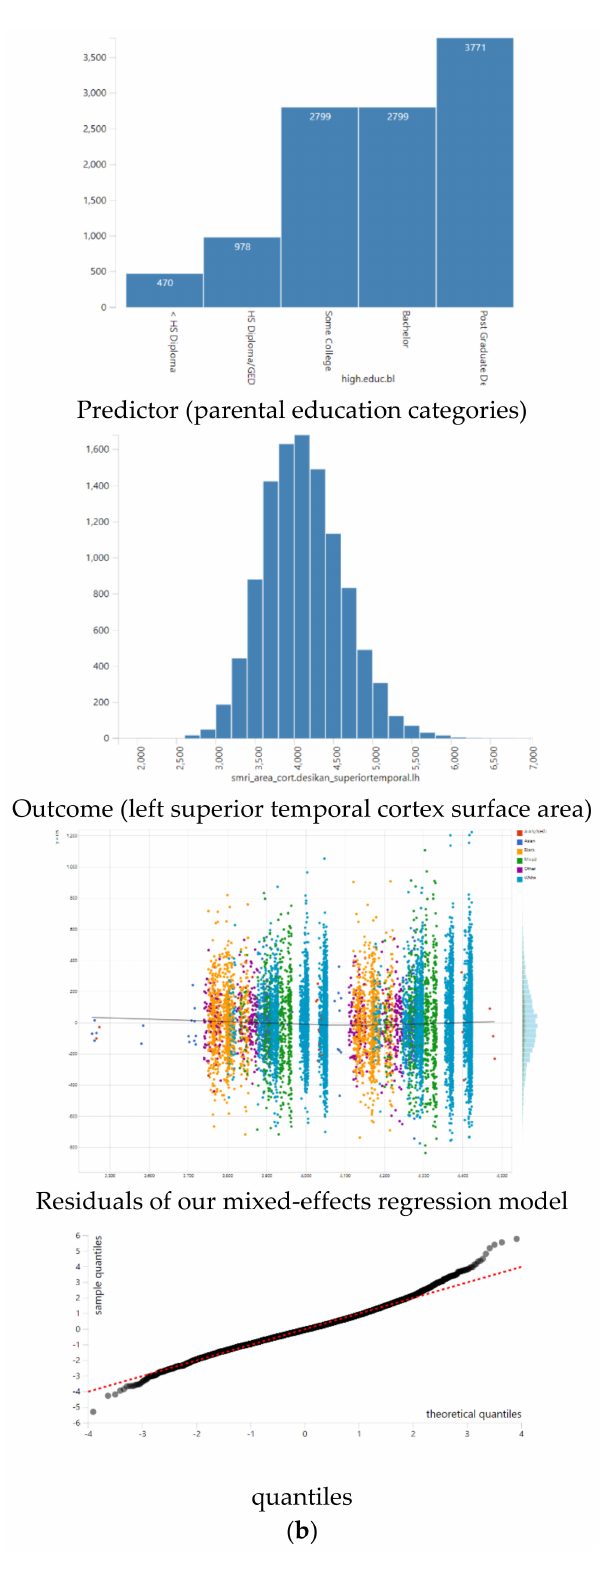
Figure A1. ( a ) Right superior temporal cortical surface area; ( b ) Left superior temporal cortical surface